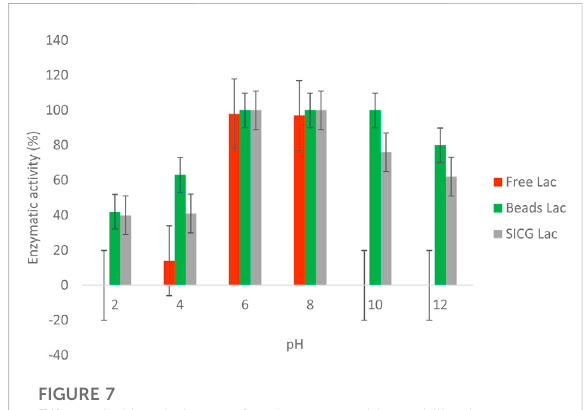
FIGURE 7 Effect of pH variation on free laccase and immobilised activities.